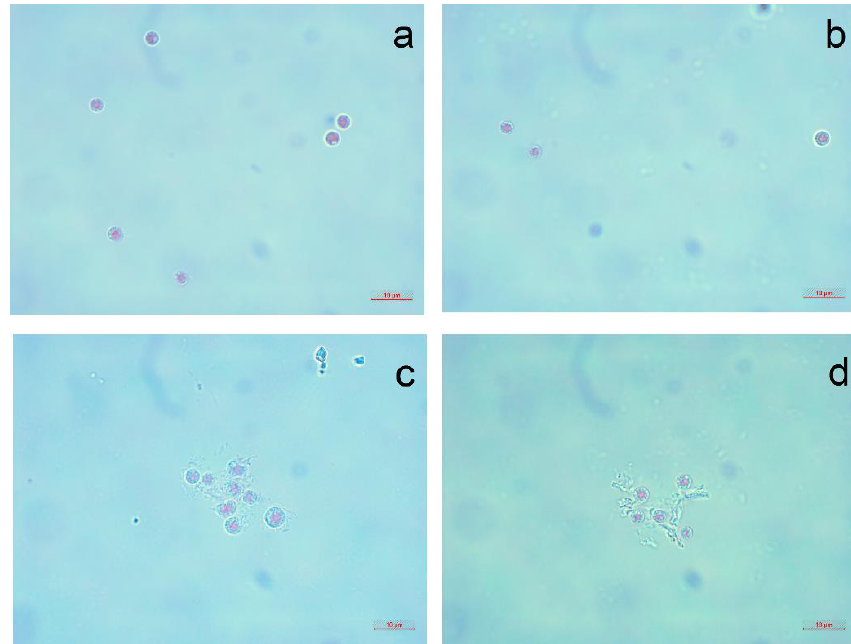
Figure 4. The red algae P. purpureum after 96 h of treatment with carbon nanofibers and silica nanotubes at concentration of 100 mg/L: ( a ) CNF-1; ( b ) CNF-2; ( c ) SNT-1; ( d ) SNT-2.